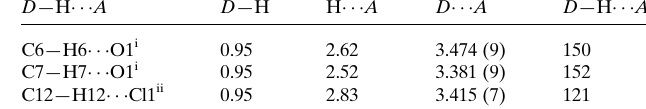
Table 1 Hydrogen-bond geometry (A˚ , (cid:4) ) for (I).